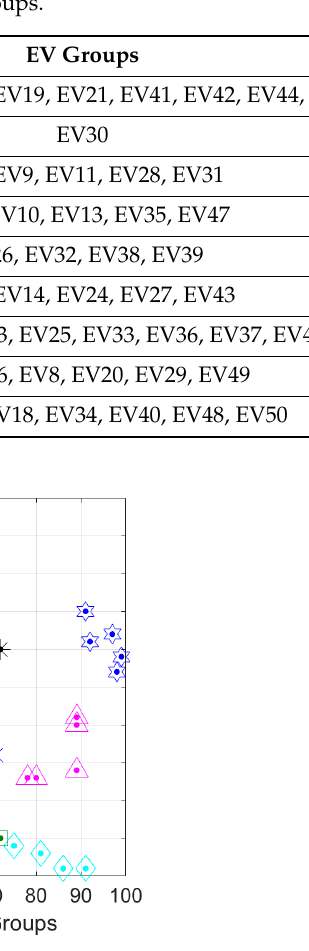
Figure 5. ( a ) Clustering results of EVs based on the state of charge value of each EV; ( b ) Clustering results of EVs based on the average vehicle daily travel value of each EV.